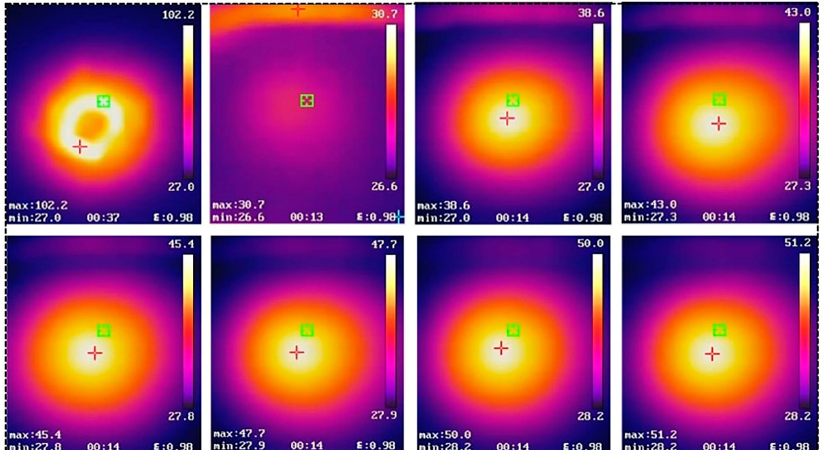
Figure 7. Infrared images of the DW/Si-10 aerogel at a point heat source of 102 °C; “max” and “min” in the Figure body express the highest and minimum temperature in the infrared region, respectively.